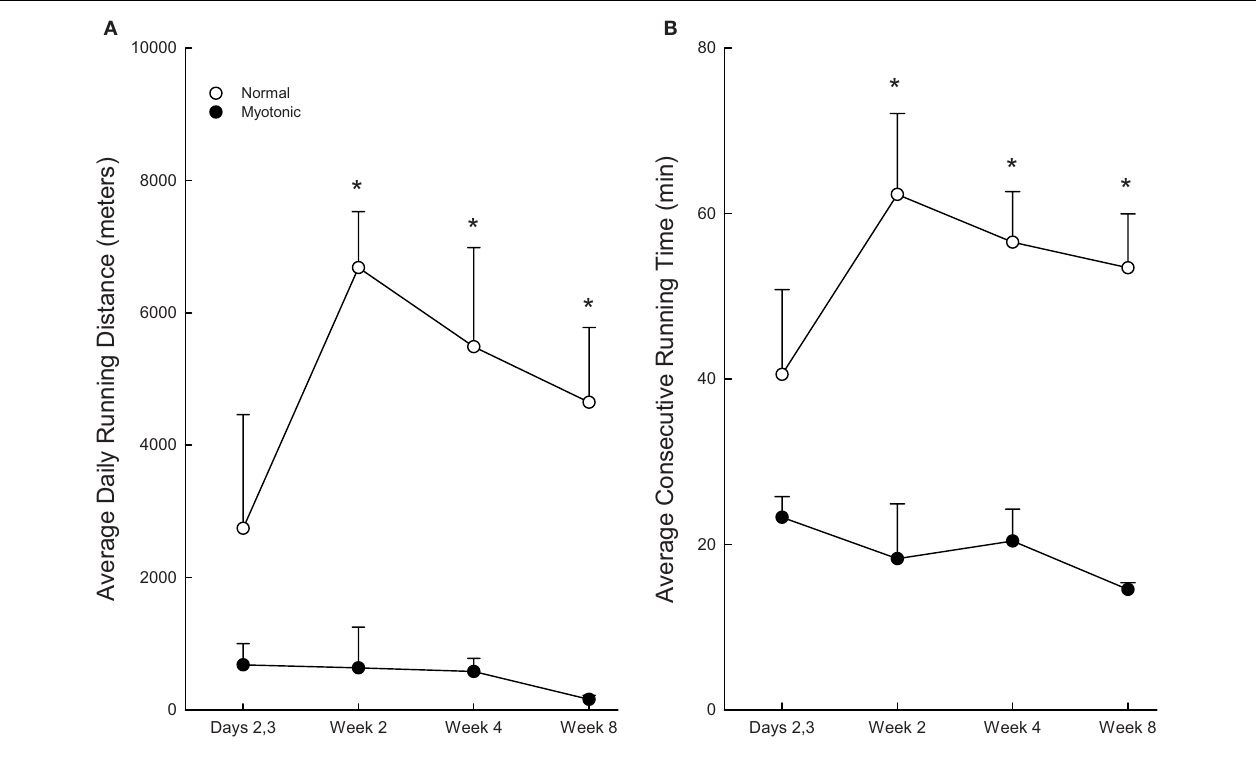
The 2, 4, and 8-week data were quantified during the last 2days of the week. Asterisks (*) indicate significant differences between normal and myotonic